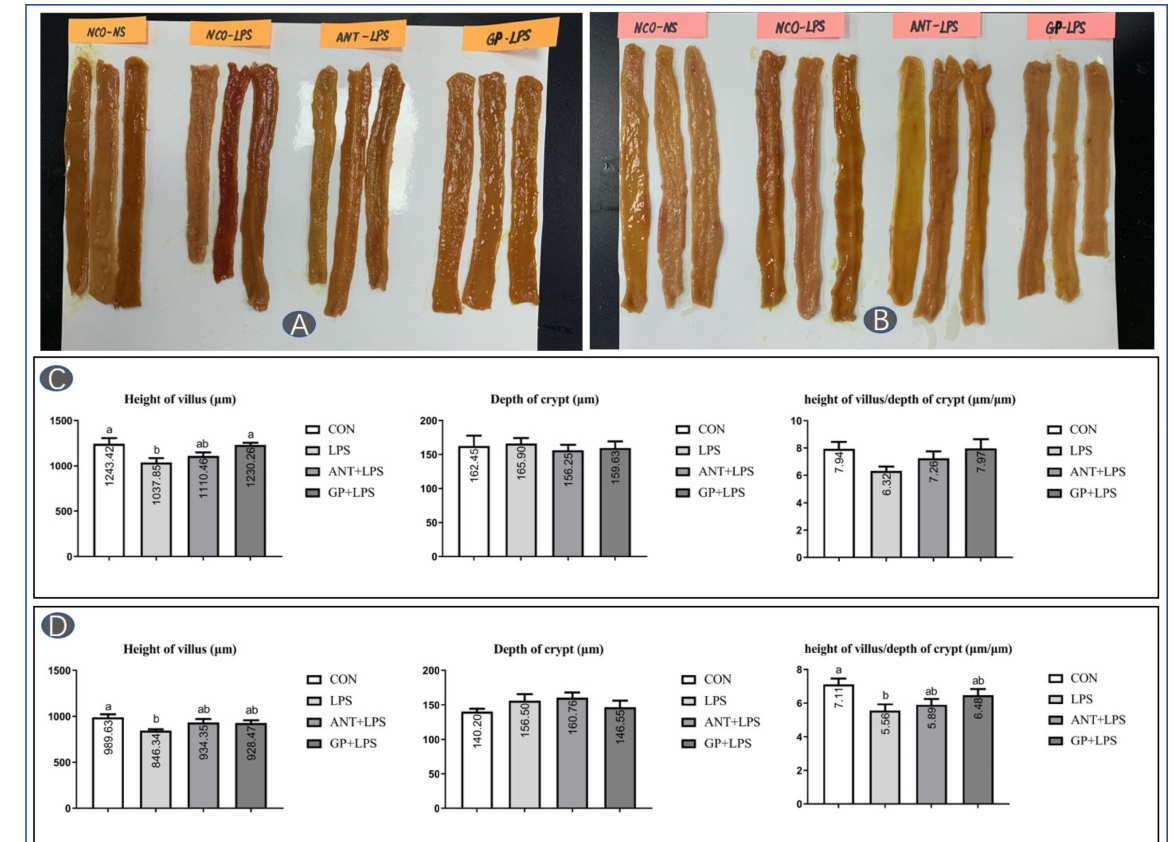
Figure 4. Effects of dietary garlic powder inclusion on intestine morphology (( A , C ) jejunum; ( B , D ) ileum) in broilers challenged with lipopolysaccharide (data were presented as mean and SEM, means that do not share the same superscript are significantly different, p <